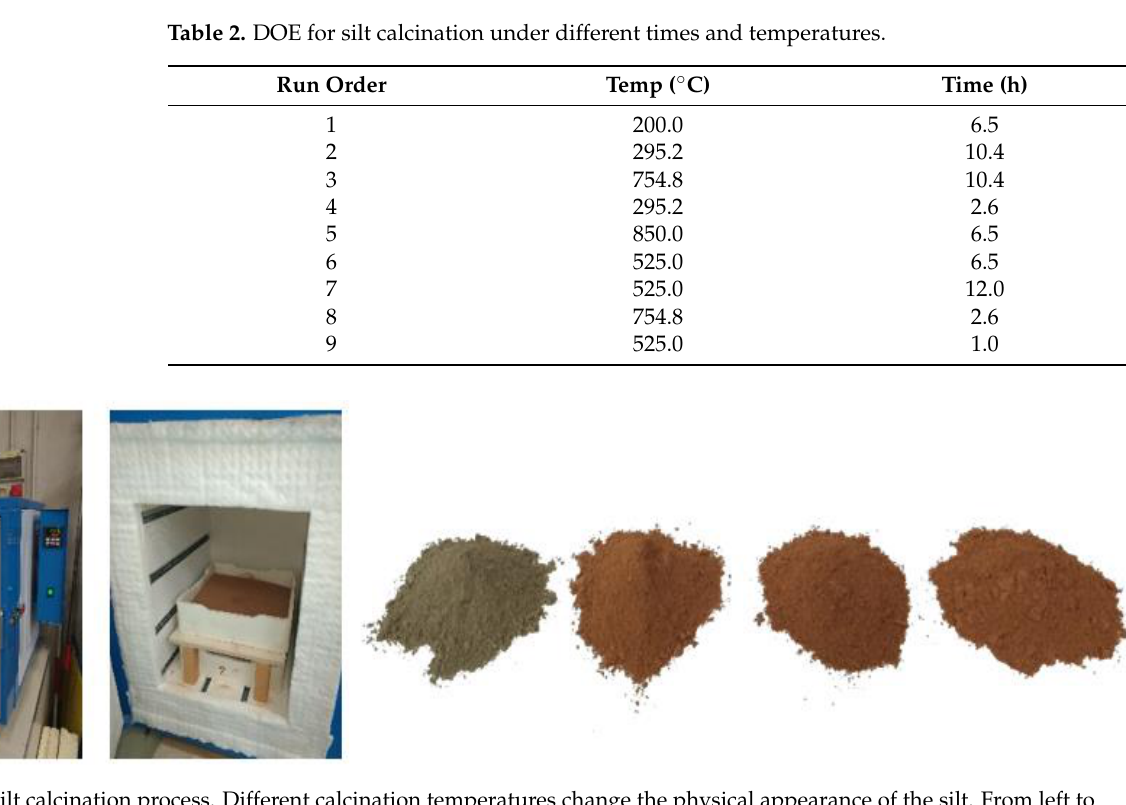
Figure 4. Silt calcination process. Different calcination temperatures change the physical appearance of the silt. From left to right, the images show the uncalcined silt and the silt calcined at 550, 750, and 850 °C.